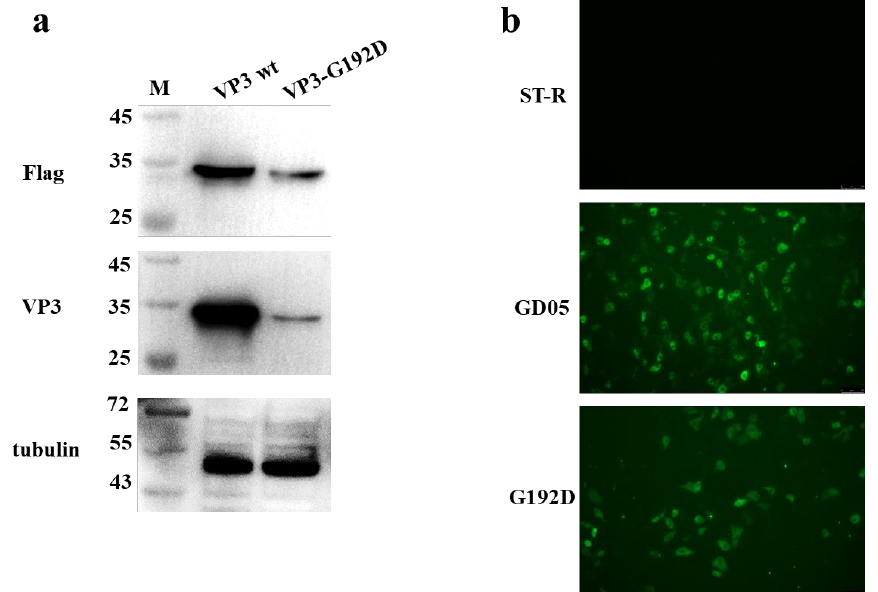
Figure 6. Identification of the reactivity between mAb 3E9 and the mutant epitope of SVA/CHN/05/2017 strain. ( a ) ST-R cells were transfected with pCAGGS-3FlLAG-VP3 and pCAGGS- 3FLAG-VP3-G192D for 48 h and then immunoblotted with anti-FLAG and anti-VP3 mAbs. ( b ) ST-R cells were infected with SVA/GD05/2017 and SVA/CHN/05/2017(G192D), respectively. IFA was performed using anti-VP3 mAb.